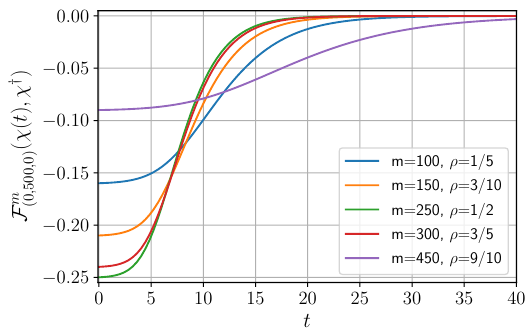
Figure 7 . Contributions to the OTOC from different charge densities ρ = m/N , for the OTOC ) . The OTOC has been restricted to the (0 , N, 0) irrep with N = 500 . This can be F m ( χ i ( t ) , χ † j compared with the overall OTOC for the case i 6 = j for large N . The charge resolved OTOC F m shows different initial values and time